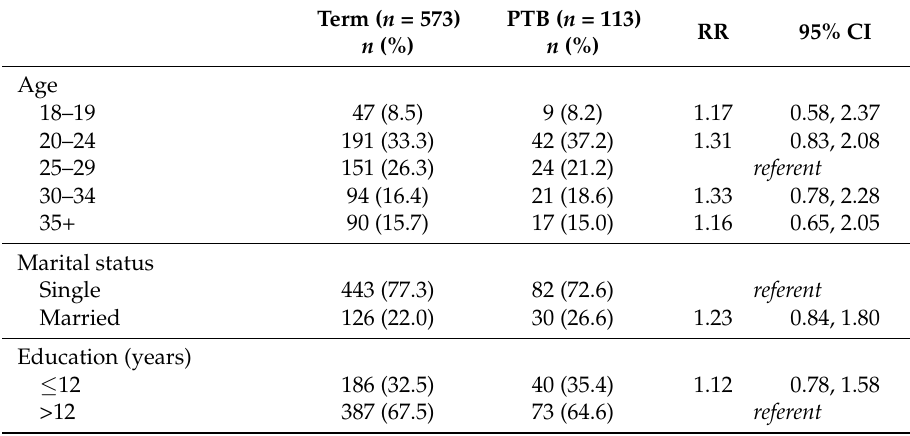
Table 2. Demographic characteristics of study participants and bivariate modified Poisson regression results; Life Influences on Fetal Environments Study ( n = 686),